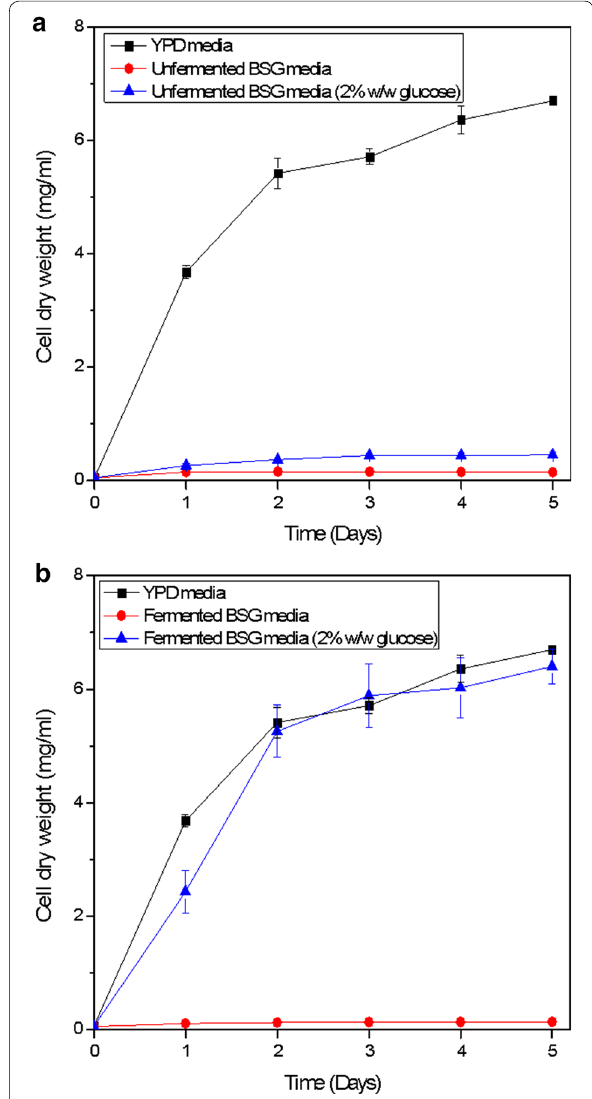
Fig. 7 Growth curve for S. cerevisiae when grown in a unfermented BSG media and b fermented BSG media compared to the growth in YPD, represented as cell dry weight (mg/ml) vs. time